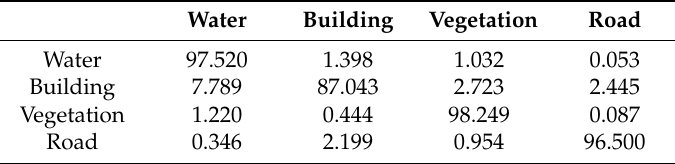
Table 1. Confusion matrix for the FCN-16s (unit: Percentage).